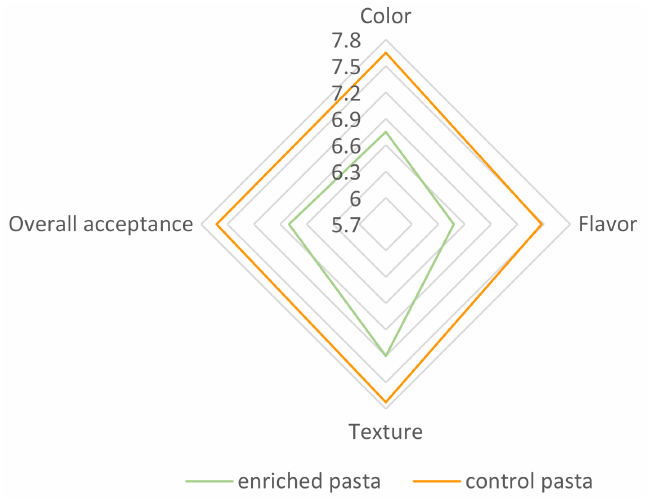
Figure 6. Sensory analysis for control (non-enriched) and enriched pasta with H. portulacoides . When asked about the purchasing preference, 37.5% of the panel members preferred pasta enriched with H. portulacoides and 62.5% preferred control pasta. Figure 7 shows the butter enriched with H. portulacoides .